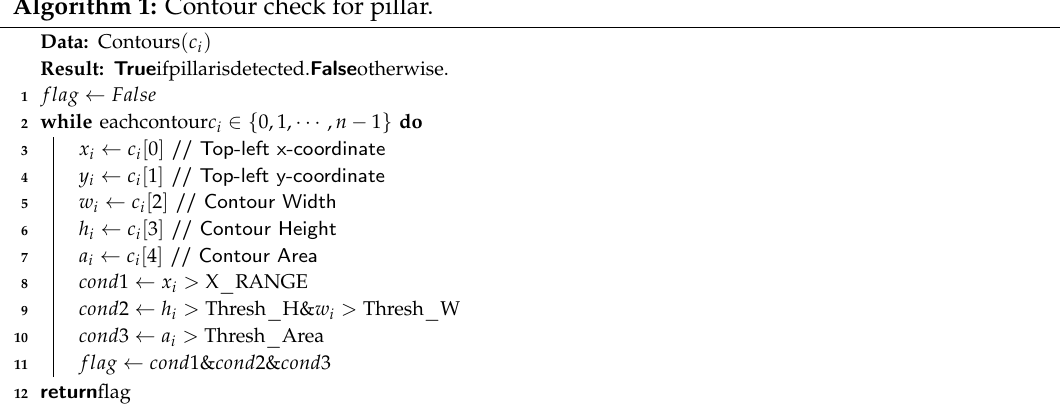
Figure 3. Masking of HSV image I hsv . The range is also shown. Algorithm 1: Contour check for